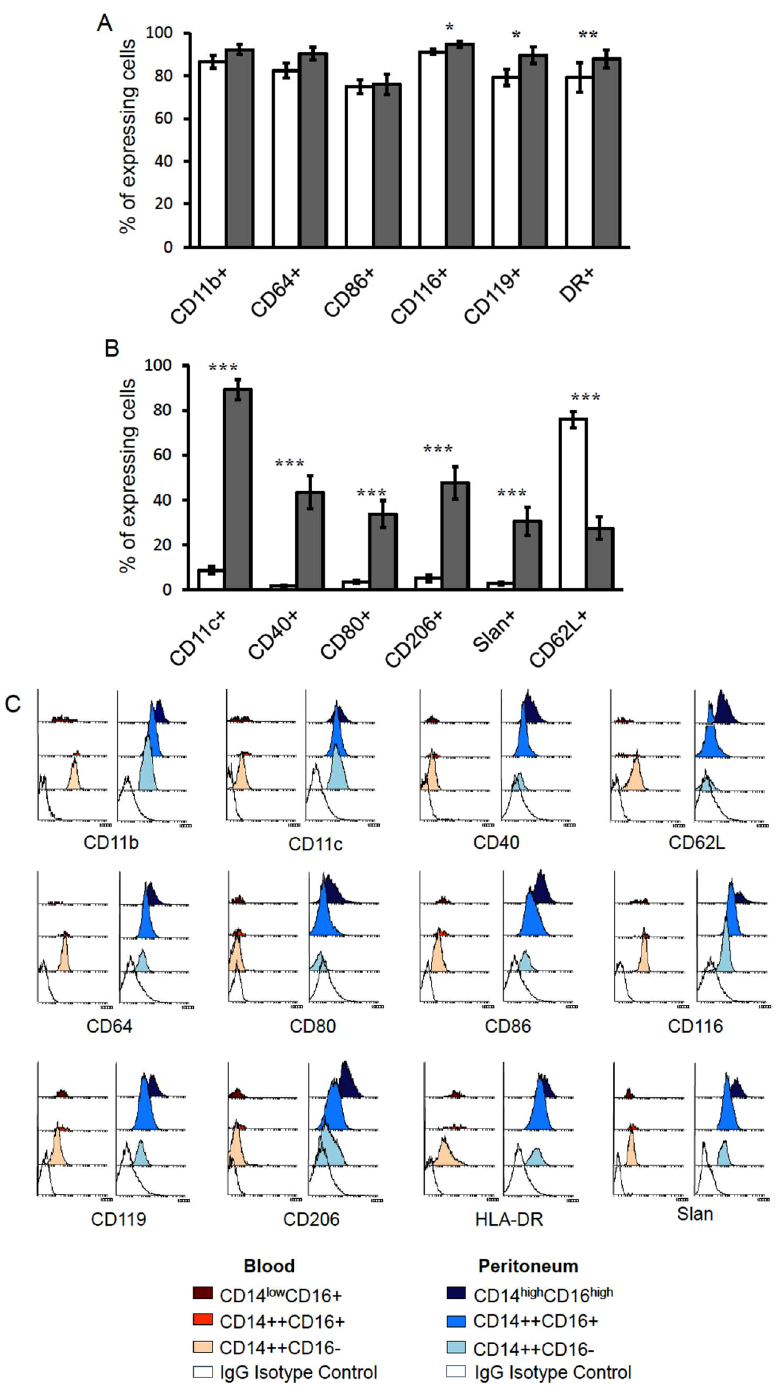
Figure 2. Flow Cytometry analysis of phenotypic characteristics of human peritoneal monocyte/macrophages compared to blood monocytes. Percentages of cells expressing several membrane markers were analyzed by FACS. A comparative analysis between blood monocytes and peritoneal monocyte/macrophages is displayed. Results on different frequencies of expression were grouped according to the similarity of expressing cells in blood and peritoneum ( A ), or to a high difference ( B ) between locations. Histograms represent the percentage of positive cells for every membrane marker indicated as mean ± SEM percentage of positive cells referred to the totality (100%) of monocyte/macrophage cells. White bars represent positive blood monocytes and grey bars positive peritoneal monocyte/macrophages. Mann-Whitney U test: * p < 0.05, ** p < 0.01, *** p < 0.001, between locations. Representative FACS mean fluorescence intensity (MFI) histograms of blood monocytes and peritoneal monocyte/macrophages for every membrane marker analyzed in the different cells subpopulations are displayed ( C